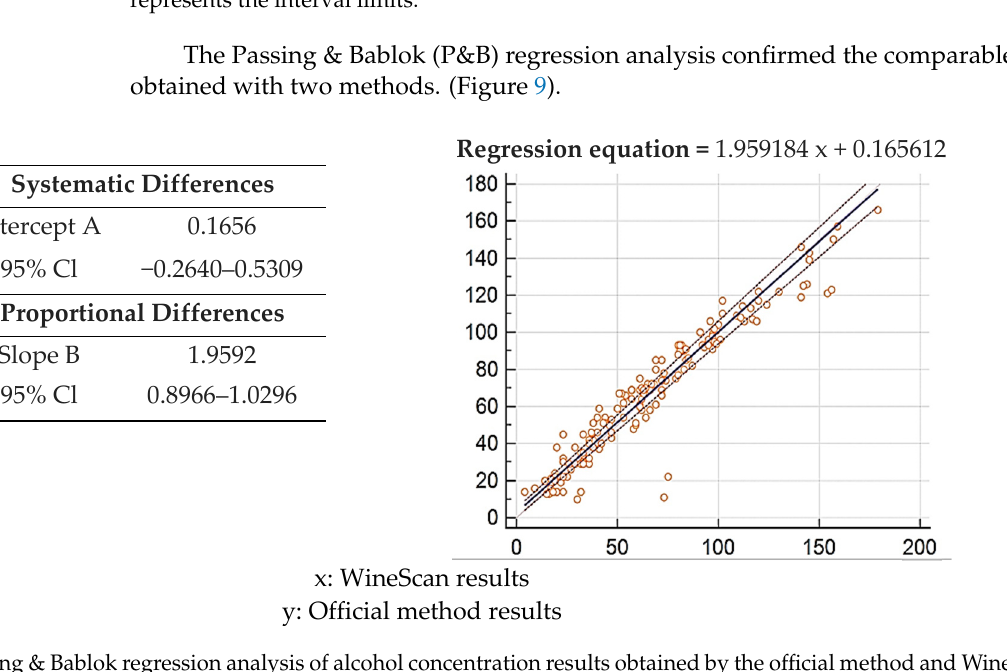
Figure 9. Passing & Bablok regression analysis of alcohol concentration results obtained by the official method and WineScan technology. The line y = x is represented by the dashed line. The regression line corresponds to the solid line.